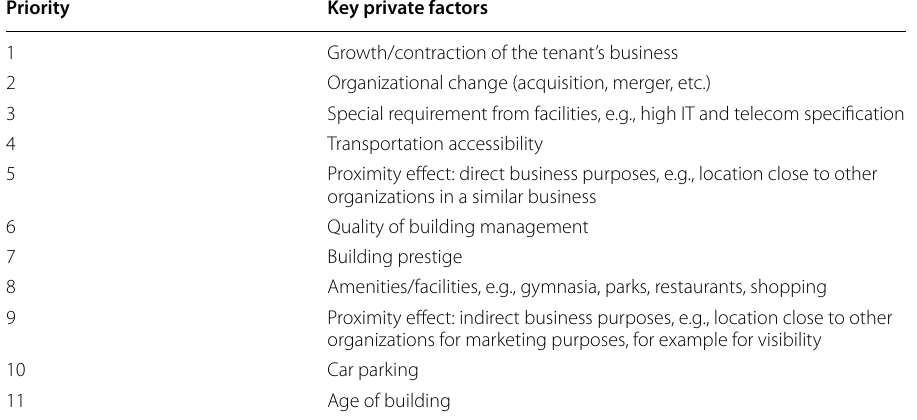
Table 6 Key private factors and